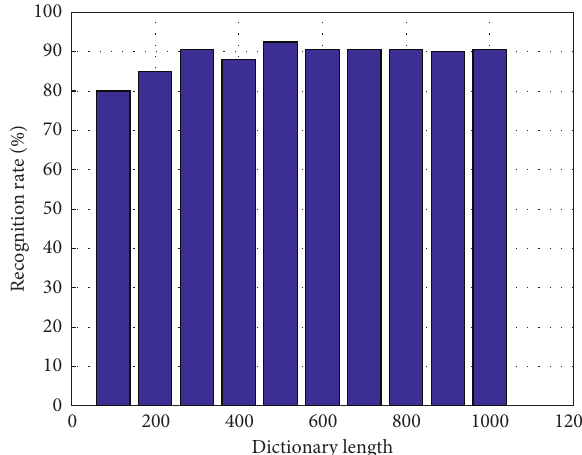
Figure 7: Recognition rate (%) for different dictionary’s length. Table 2: Recognition rates (%) for each dictionary built from an image of the training set. Image 1 Image 2 Image 3 Image 4 Image